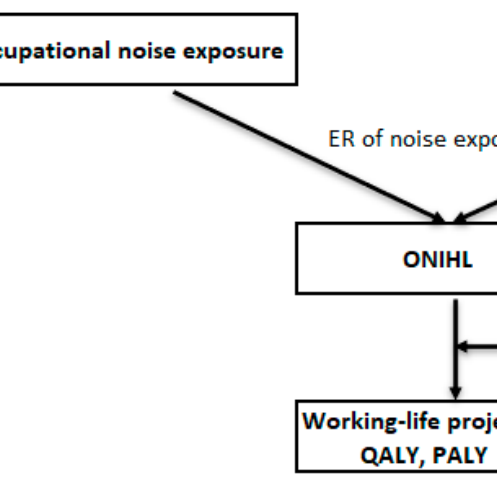
Figure 1. Study method flowchart (ER: excessive risk) .